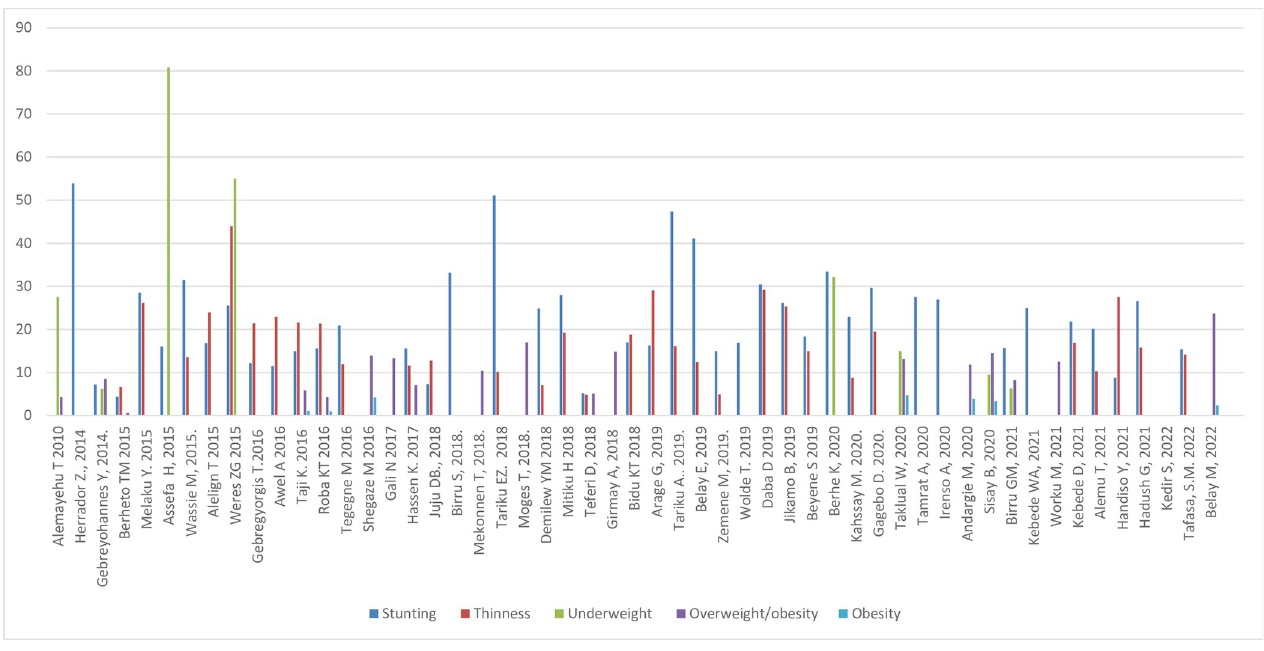
Fig 5. Trends in the nutritional status of adolescent in Ethiopia over the last 10 years. https://doi.org/10.1371/journal.pone.0280784.g005 (10.5% moderate and 1.3% severe) in the age group 15–19 years [69]. Iron deficiency (ferritin < 15 μ g/L) was 8.6% and iron deficiency anemia (IDA) was 2.6% in the age group 12– 14; equivalent data for the 15–19 year age group were 10.0% and 3.2% [69]. Site specific studies in northwestern Ethiopia indicated a prevalence of anaemia of 13.4% (Hb < 12 g/dl [68] and 25.5% (92.4% mild, 5.9% moderate and 1.7% severe) with the odds of having anaemia higher in those with inadequate diet diversity score (DDS) (AOR = 2.1;95%